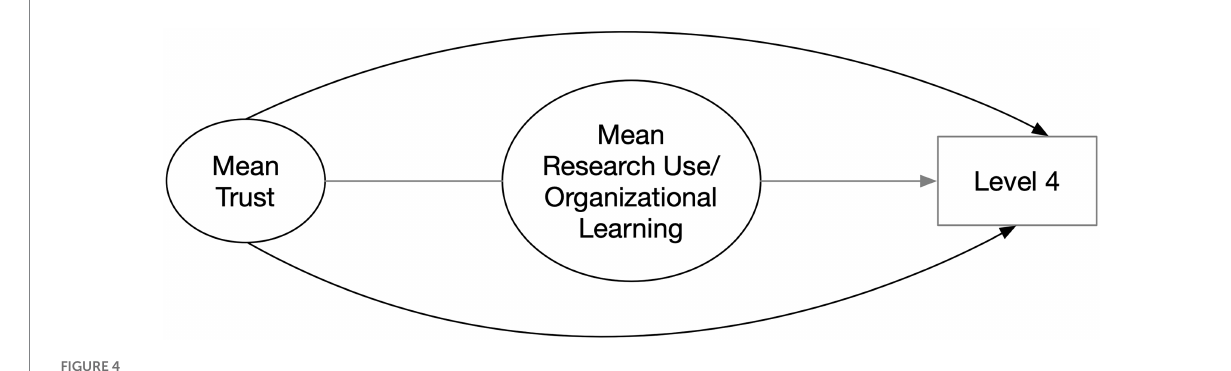
FIGURE 4 Path model on level-2 (73 schools).